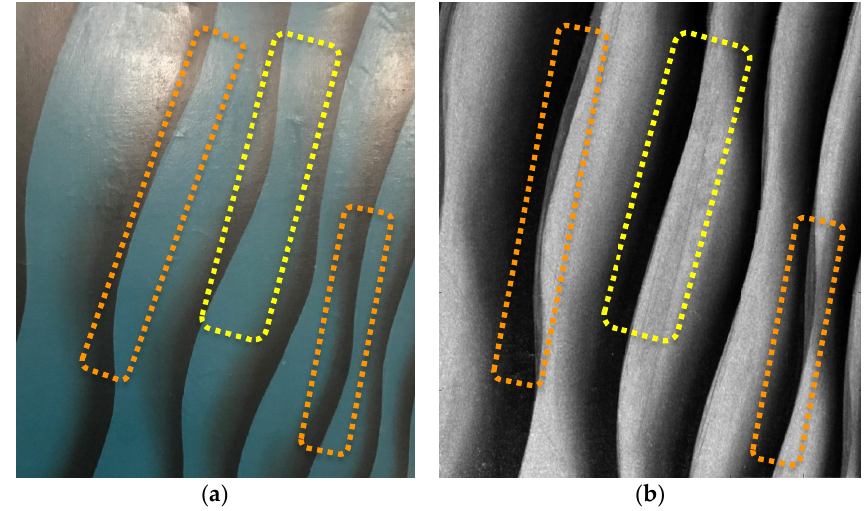
Figure 16. IR-ITR experiment: ( a ) photographic image of an acrylic-colored canvas (Photo: S. Ceccarelli); ( b ) IR-ITR image where the lines and shades are different from the visible image, revealing changes from the original drawing and the realization technique (dashed shapes indicate the different elements in relation to the visible image), (Elaboration carried out by ENEA team with the custom software